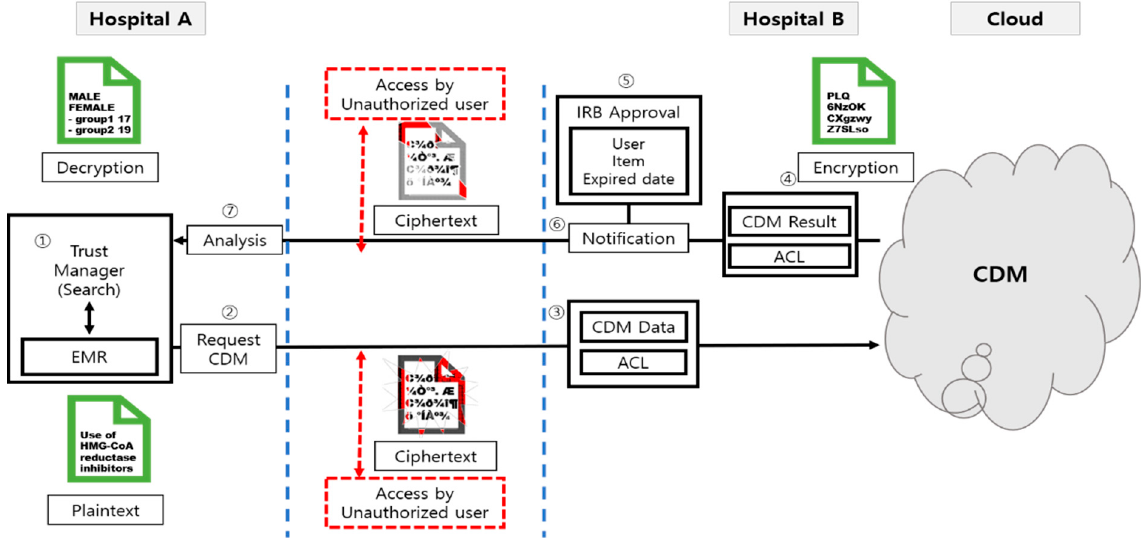
Figure 15. Flow of access control in cloud CDM. ① Search in trust manager ② Request data from the hospital where the data are available ③ Request for CDM data, attachment of access control list ④ Request result, ACL ⑤ IRB approval (user, data approval range, period of use) ⑥ Approval notice ⑦ User analysis.